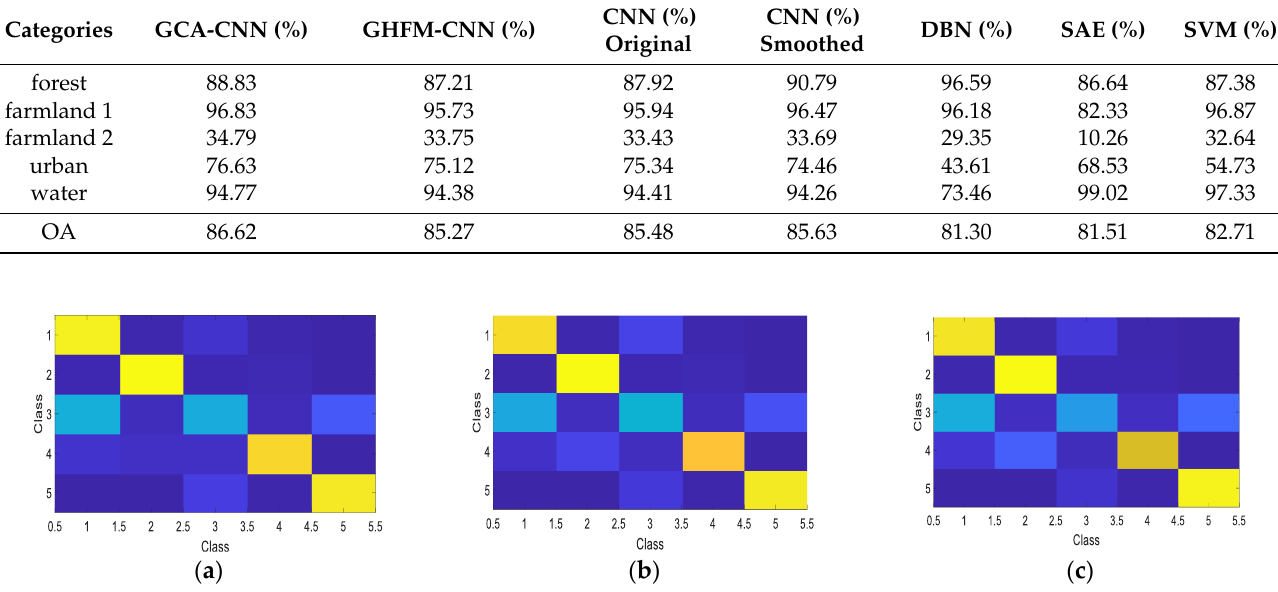
Table 3. Accuracies on Flevoland SAR image.